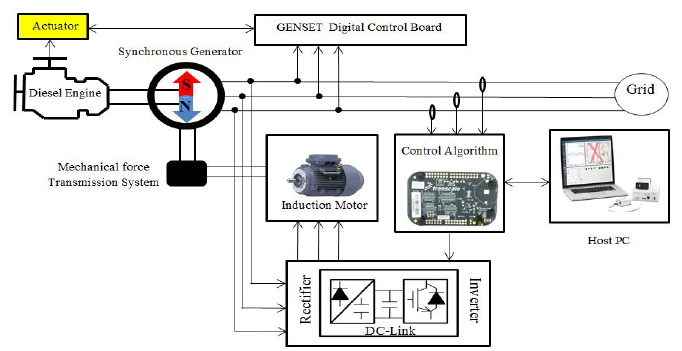
Figure 1. Configuration of the variable speed diesel generator (VSDG).